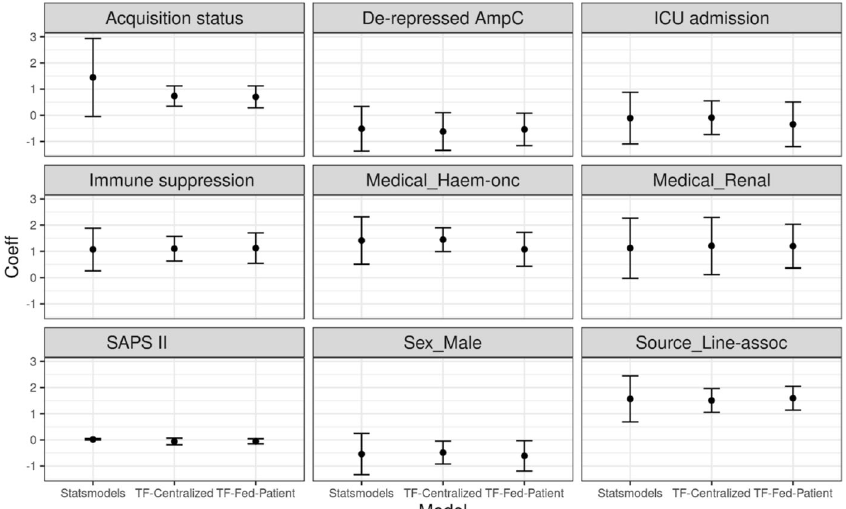
Fig. 4 The estimated coef fi cients of Statsmodels (GLM), TF-Centralized (Tensor fl ow Probability) and TF-Fed-Patient (Tensor fl ow Probability with Federated Learning, using patient as the unit). The plots show the coef fi cients and their 95 %con fi dence intervals of nine variables of different univariate logistic regression models. The signi fi cance of all models and variables is almost consistent with the original study: eight over nine variables have the same conclusions and only one (Acquisition status) does not (TF-Centralized and TF-Fed-Patient both show it is signi fi cant, while GLM and the original study state otherwise). In the original study, the variable has a p value of 0.06 which lies near the borderline of signi fi cance ( p ≤